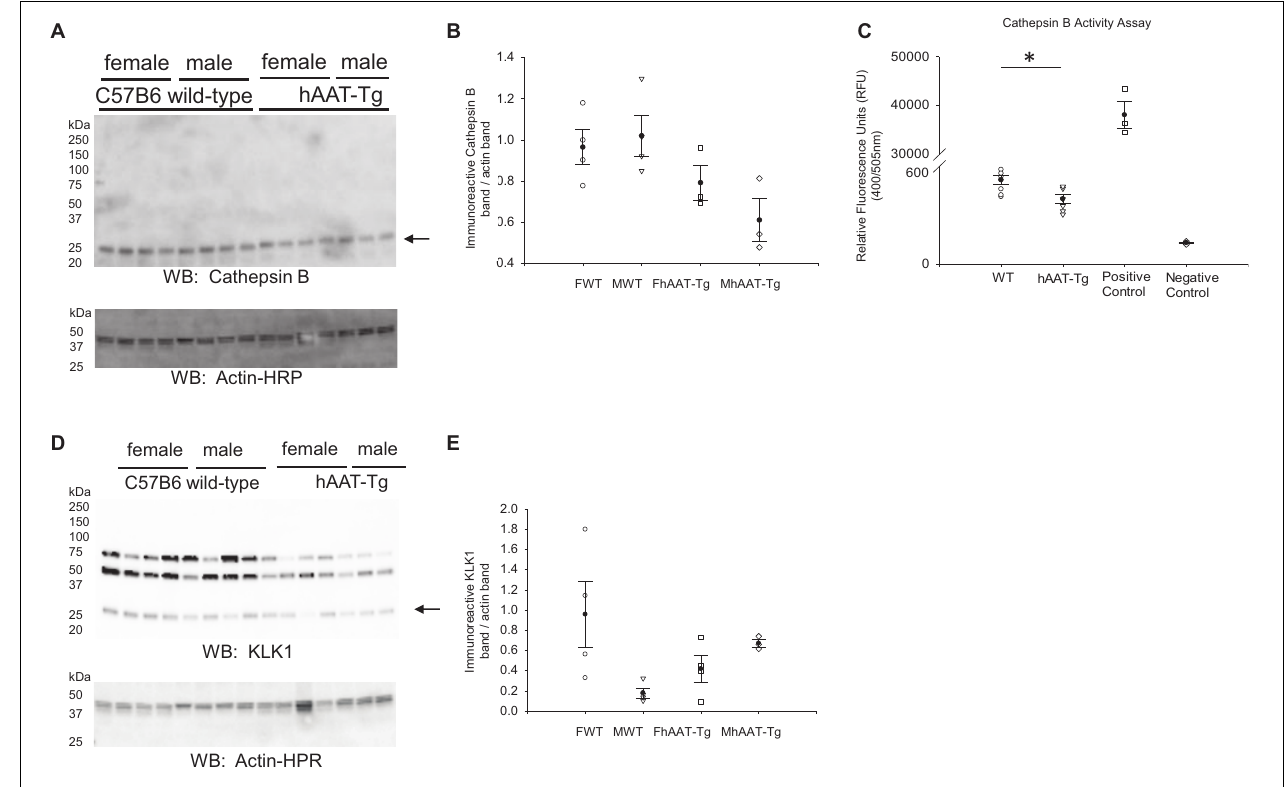
FIGURE 4 | Western blot analysis of cathepsin B and kidney kallikrein protein expression from the soluble fraction of kidney cortex lysates. (A) Western blot analysis of the cathepsin B protein expression from the soluble fraction of kidney cortex lysates harvested from female and male hAAT-Tg mice and C57B/6 wild-type mice. (B) Densitometric analysis of the immunoreactive cathepsin B band in panel (A) normalized to actin. Lane 11 of the cathepsin B blot and the corresponding actin blot was omitted from the analysis. (C) Cathepsin B activity assay showing endogenous cathepsin B activity in kidney cortex lysates of wild-type and hAAT-Tg mice. (D) Western blot analysis of the kallikrein protein expression from the soluble fraction of kidney cortex lysates harvested from female and male hAAT-Tg mice and C57B/6 wild-type mice. (E) Densitometric analysis of the immunoreactive kallikrein band in panel (D) normalized to actin. N = 7 hAAT-Tg (4 female and 3 male) and N = 8 C57B/6 (4 female and 4 male) mice maintained initially on a normal salt diet and then a high salt diet and euthanized in the AM. These results were analyzed using a One-Way ANOVA followed by a Holm-Sidak comparison and a Student’s t -test. We used a significance level of * p < 0.05.